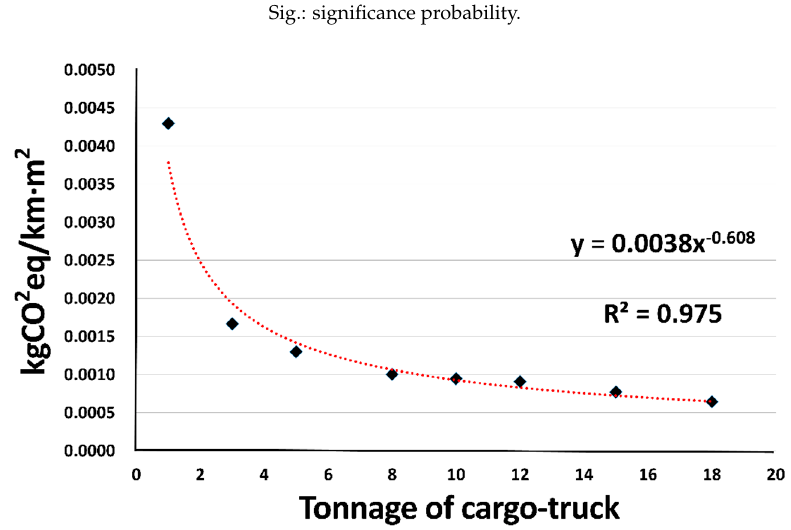
Figure 4. Diagram of GHG emission per weight of cargo truck in tons, based on units of ACS area.